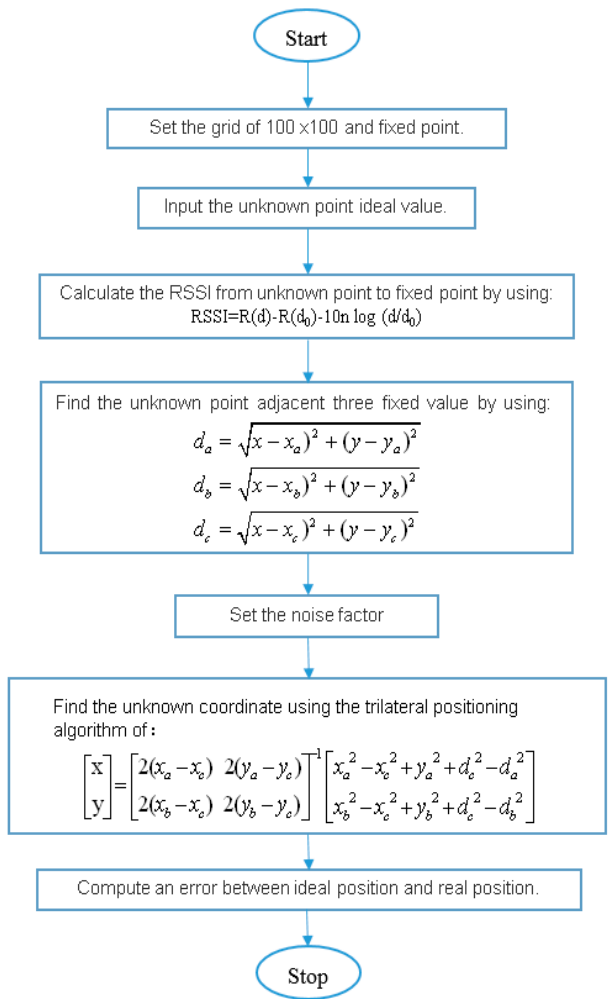
Figure 4. Flow chart for computing the localization of robot or internet of things (IOT) sensor.